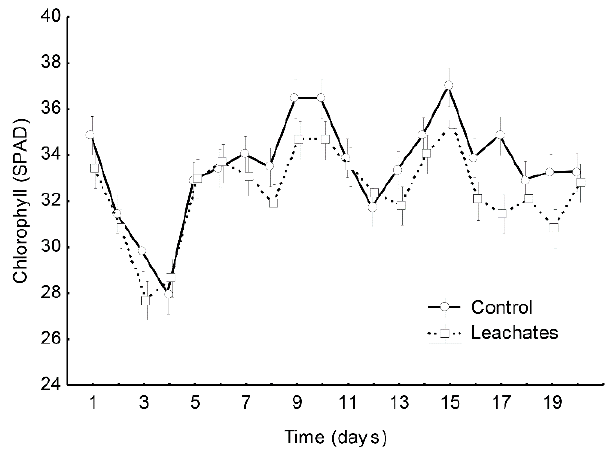
Figure 1. Chlorophyll SPAD readings in M. spicata plants under leachates of inorganic and vermicompost leachate fertilizers. Vertical bars represented mean ± standard error.